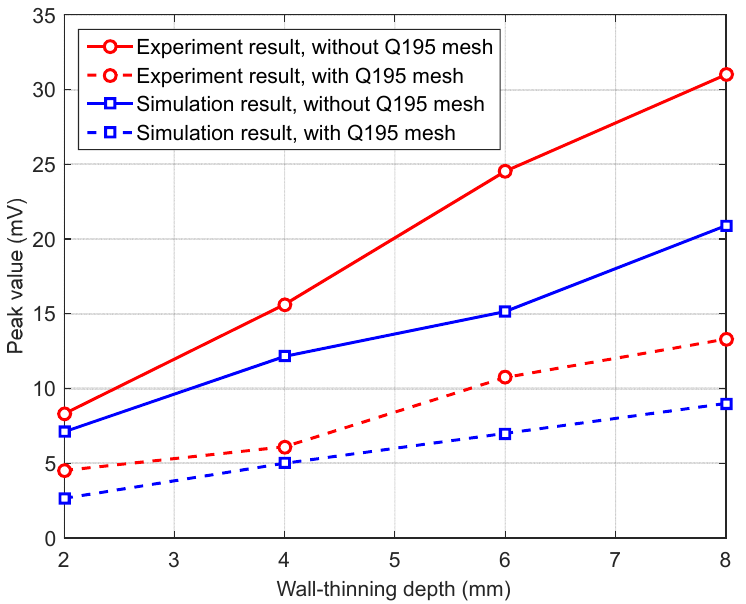
Figure 14. Comparison of the variations between the PECT experiment and the simulation signal peaks against the wall-thinning depth.